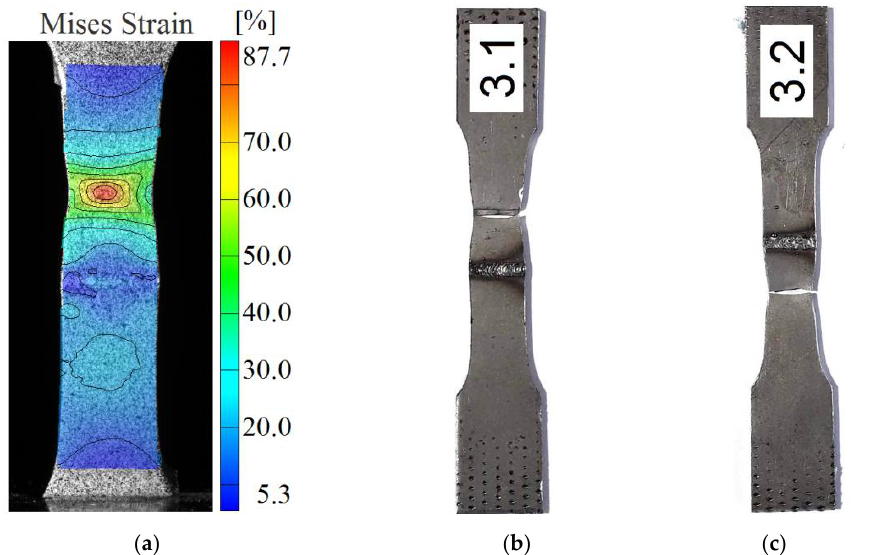
Figure 7. ( a ) The equivalent von Mises strain field in the gauge length for Sample 3; and ( b ) and ( c ) repetitions of welding conditions corresponding to Sample 3.